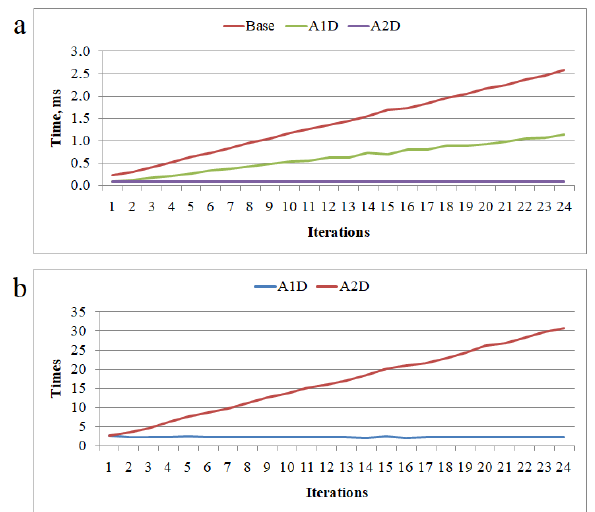
Figure 8. Comparison of Arnold transform calculation in basic method (Base) and using tables A1D and A2D for 32×32 blocks: a) calculation time, b) speedup.